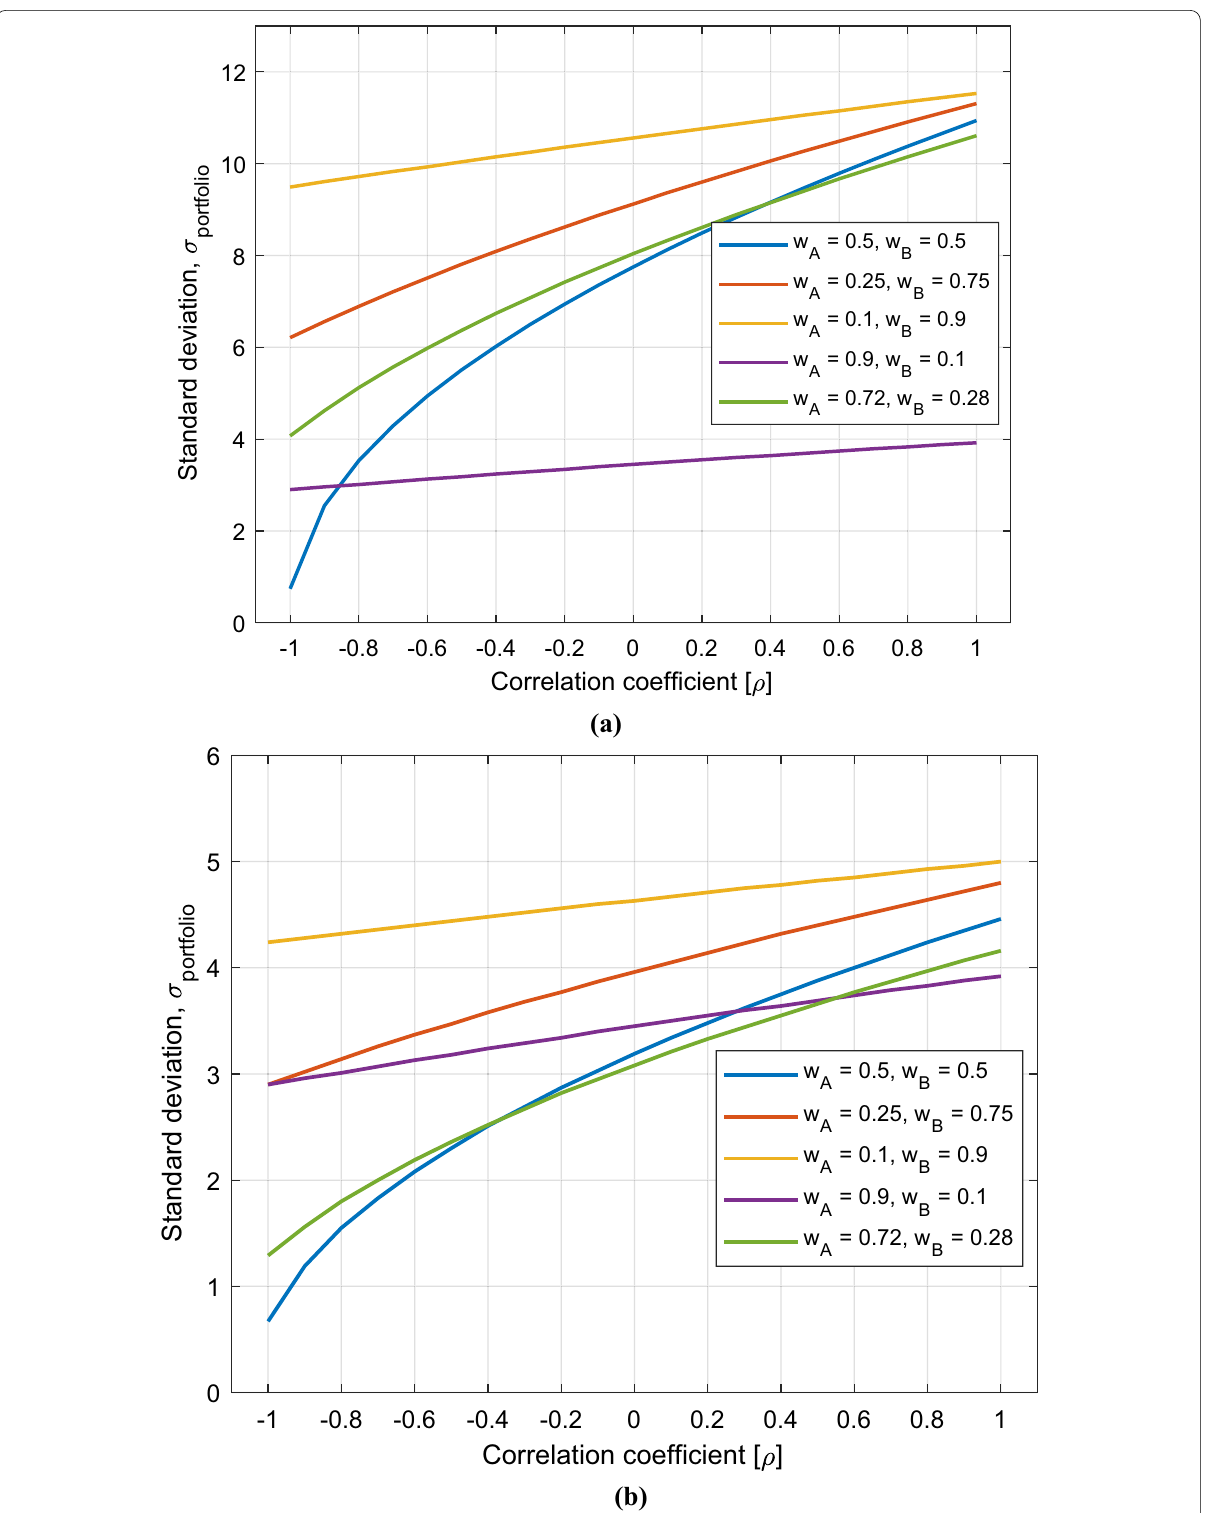
Fig. 15 Graph showing change in standard deviation with correlation coefficient for a composite portfolio a S&P 500, b BSE